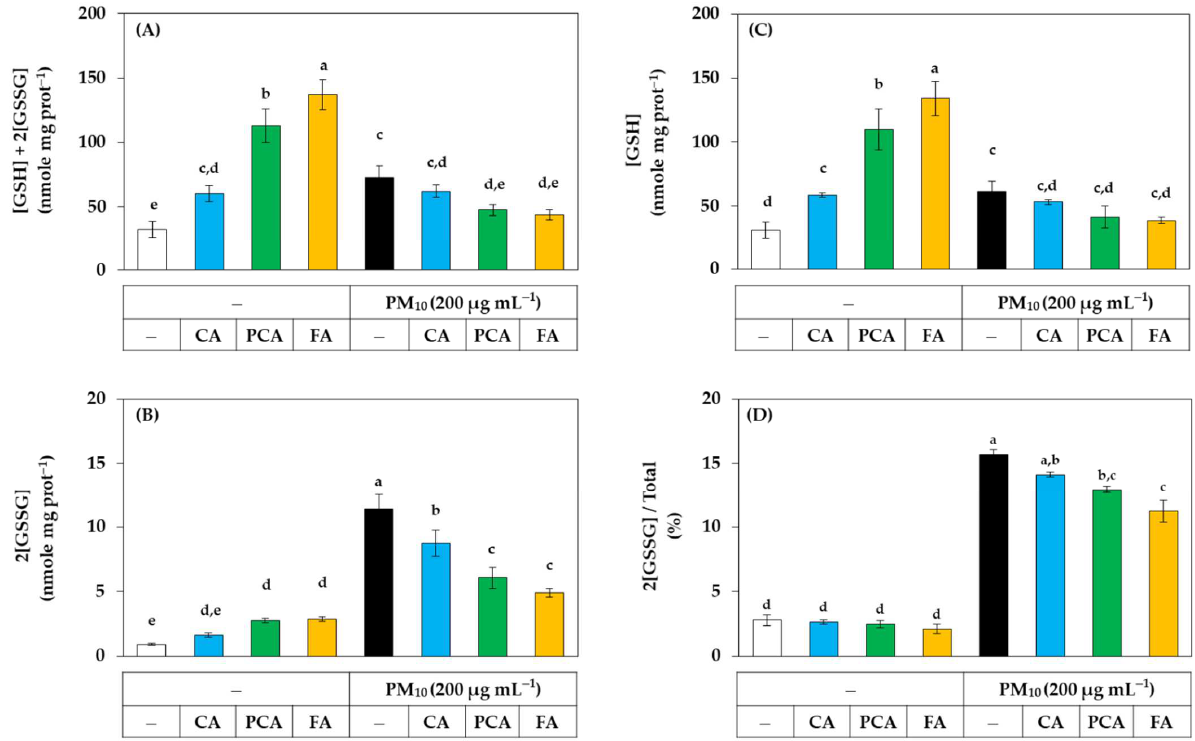
Figure 9. Effects of caffeic acid (CA), p- coumaric acid (PCA), and ferulic acid (FA) on the contents and ratios of glutathione (GSH) and glutathione disulfide (GSSG) in HaCaT keratinocytes exposed to PM 10 . Cells were treated with each compound at 30 μM and cultured in the absence or presence of PM 10 (200 μg mL −1 ) for 24 h. The total contents of GSH plus GSSG ( A ) were subtracted by the GSSG contents ( B ) to calculate the GSH contents ( C ). The ratios of GSSG contents to the total contents were presented in ( D ). Data are presented as mean ± SD ( n = 3). Duncan’s multiple range test was performed to compare all group means to each other. Groups that share the same letters (a–e) do not have significantly different means at the p < 0.05 level.